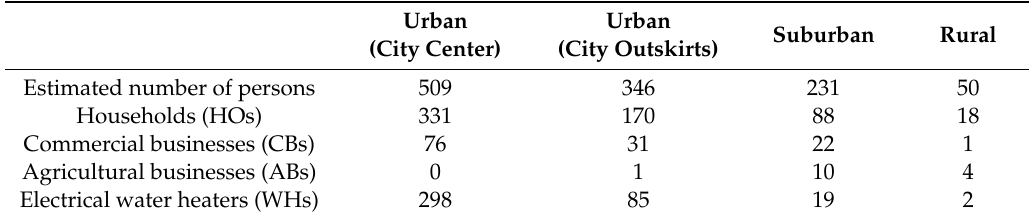
Table 2. Number of persons (estimated) and number of conventional grid customers depending on consumer type and grid